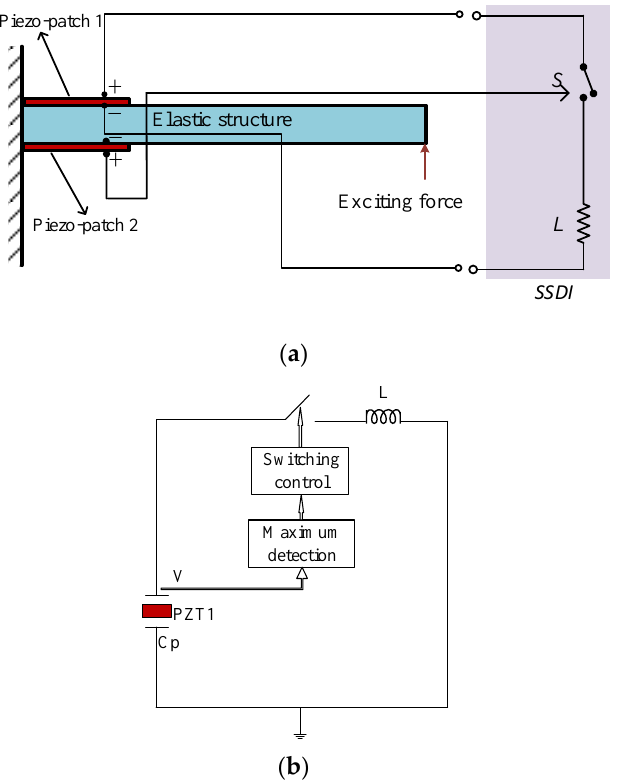
Figure 1. Configuration of the single beam with the SSDI shunt: ( a ) model of the single beam with the SSDI shunt; ( b ) the equivalent circuit of the SSDI shunt.